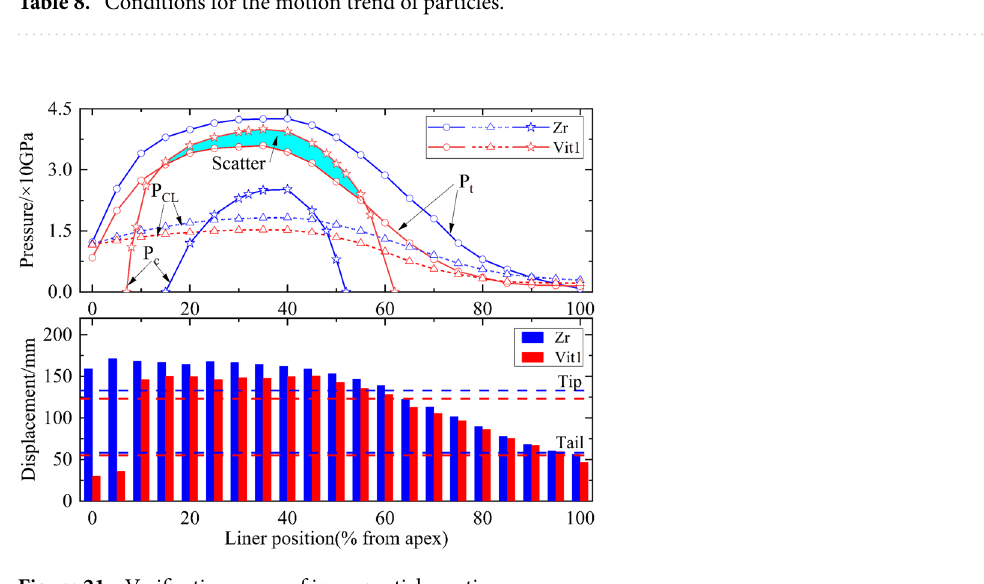
Figure 21. Verification curve of inner particle